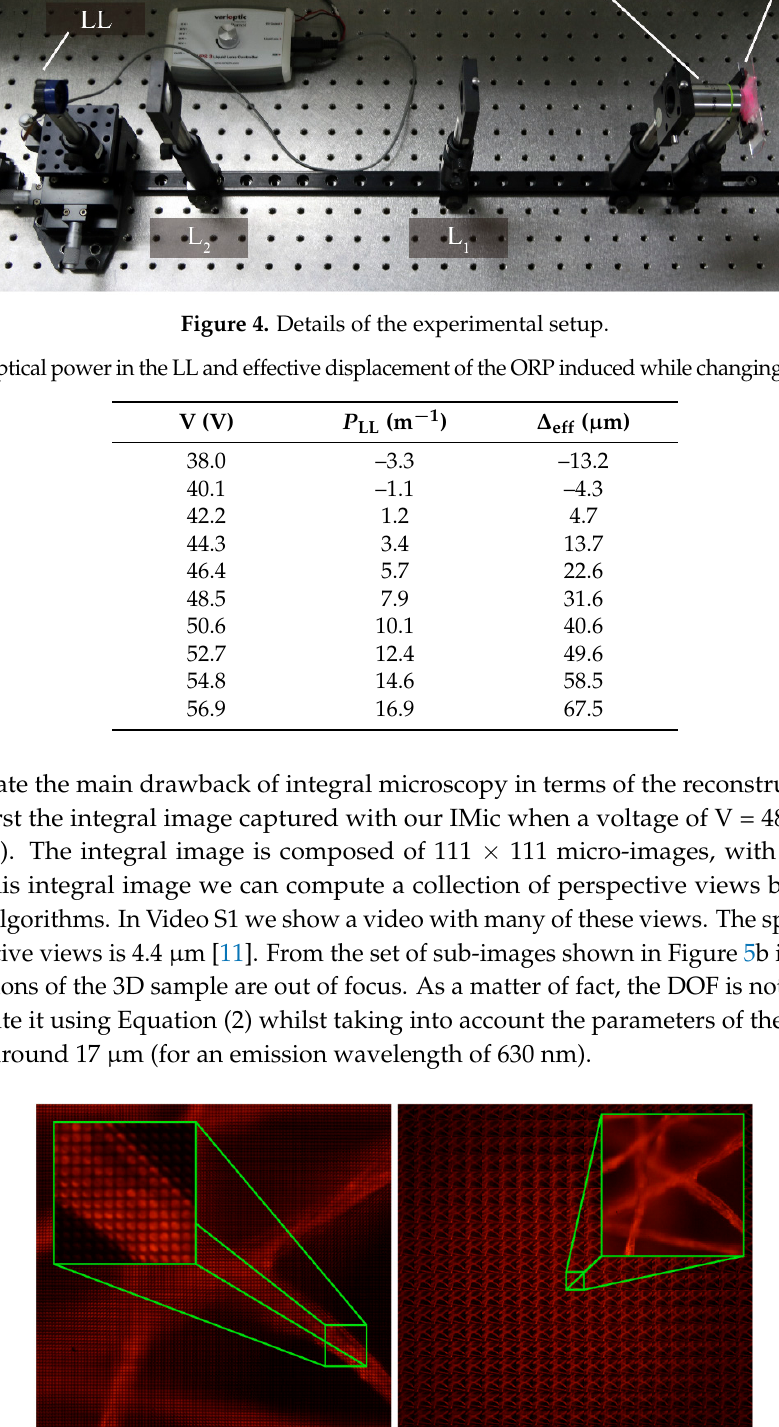
Figure 6. Comparison of the depth reconstruction by the conventional method ( left ) and with the proposed method ( right ). Finally, we can compare this improvement in the DOF in terms of the perspective views. In Figure 7a, we show the central view of the integral microscope extracted from the sub-images shown in Figure 5b. On the other hand, Figure 7b shows the same central view of the 3D sample, but only